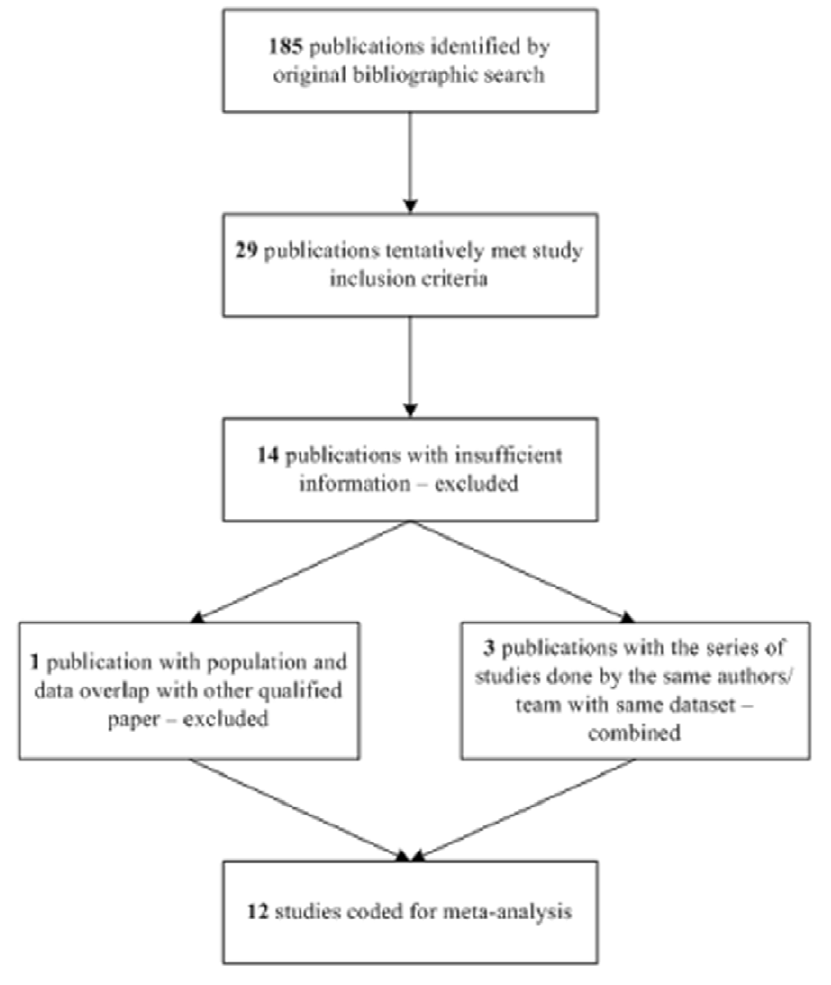
Figure 1. Flow Chart of Study Selection Process.